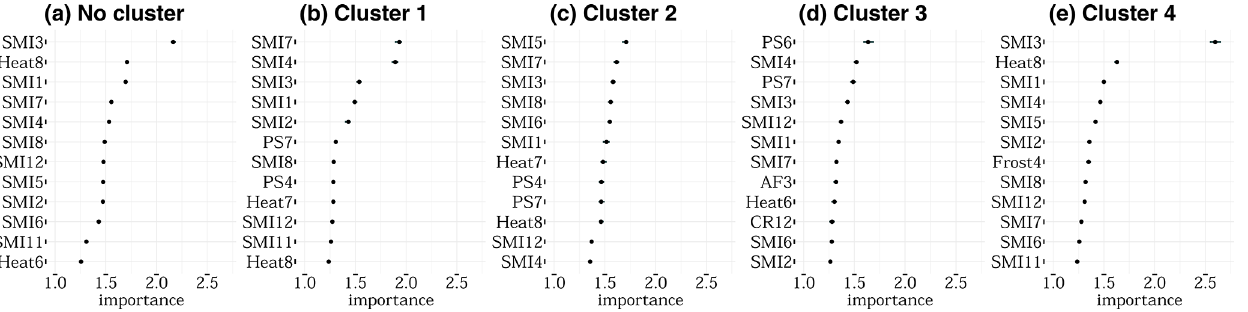
Figure A4. Variable importance of the 12 most important features for no cluster (a) , cluster 1 (b) , cluster 2 (c) , cluster 3 (d) , and cluster 4 (e) derived with the PAM (4) cluster algorithm and size combination only considering the uppermost 25cm of the soil column. The importance ranking is established with 50 repetitions of permutation. SMI represents the soil moisture index for the uppermost 25cm of the soil column, PS stands for days without rain in a given month, Heat stands for days with a maximum temperature of more than 30 ◦ C, Frost stands for the number of days below − 5 ◦ C (as only April is indicated), and AF stands for days with a minimum temperature below − 3 ◦ C as well as a maximum temperature of + 3 ◦ C (same day). The number indicates the month; 10, 11, and 12 refer to the year before. For example, Frost10 represents black frost in